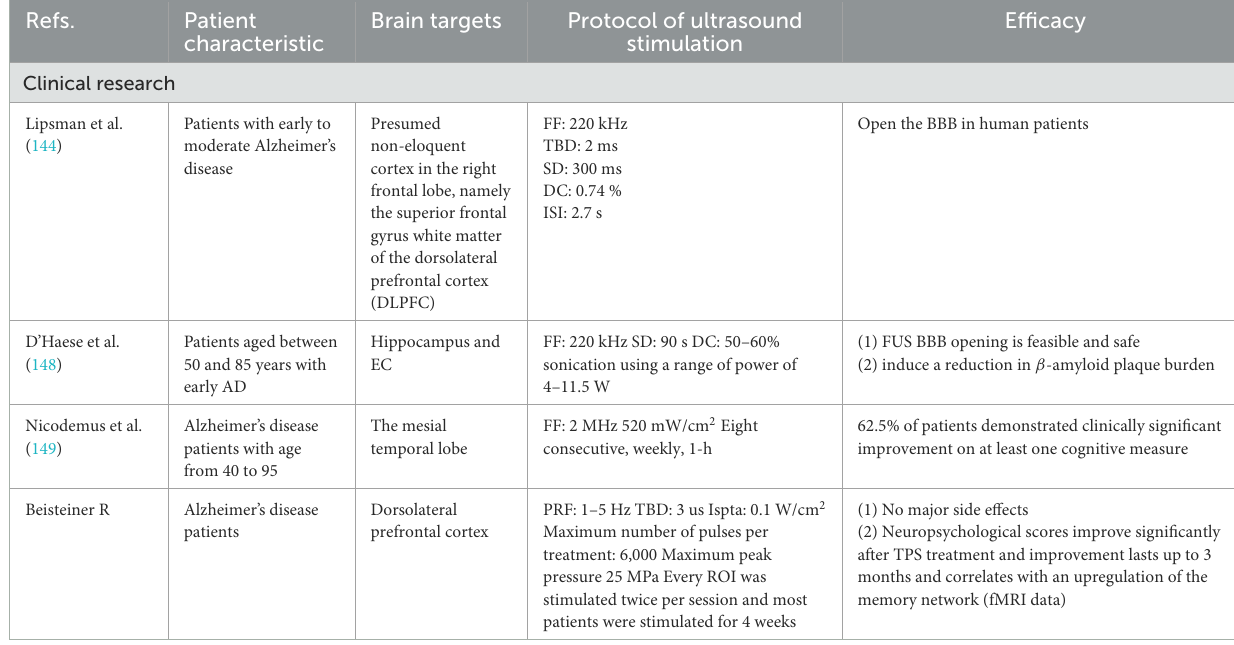
(Table 3). In the context of the transient opening of the BBB, it is worth noting that the BBB in the brains of AD model mice was